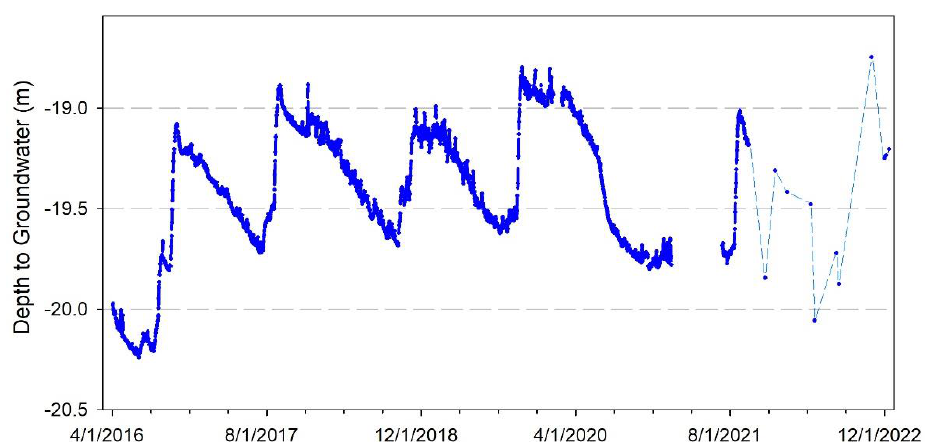
Figure 5. Daily maximum groundwater levels obtained from hourly or bi-hourly records from 1 April 2016 to 16 December 2022. Dashed lines indicate potential groundwater level trajectory connecting manually measured data points in late 2021 and 2022.